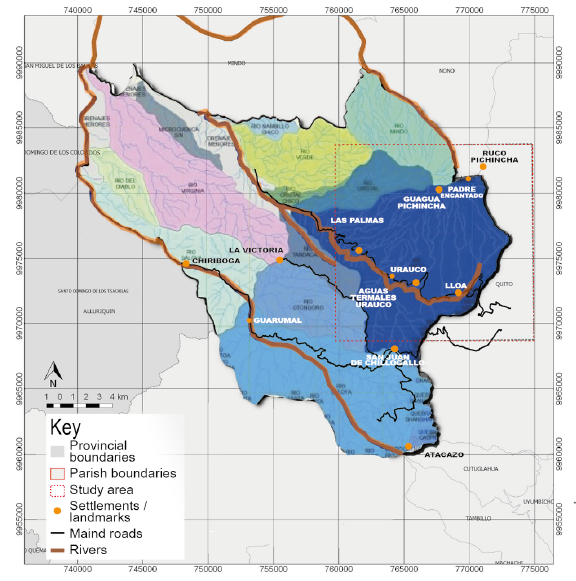
Figure 5: Hydrographic map